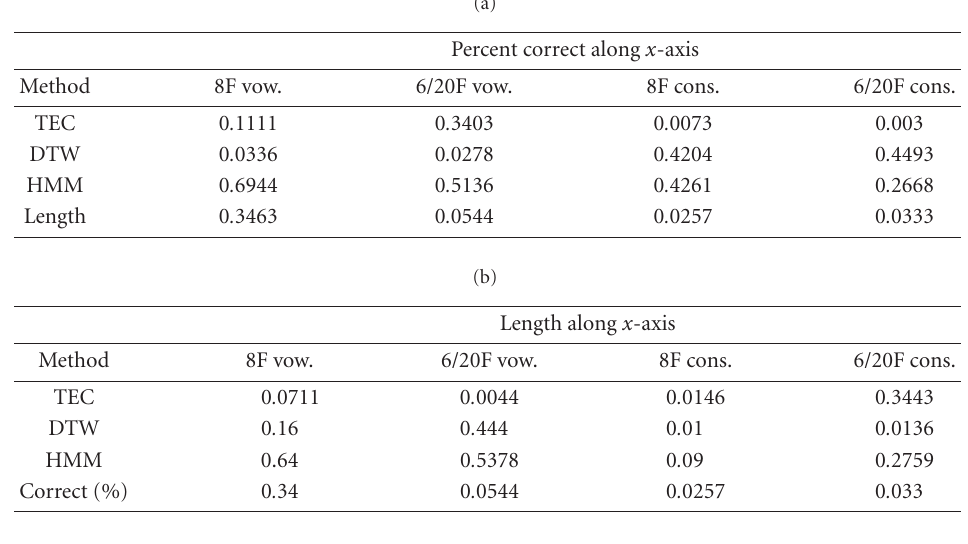
Table 3: Summary of coe ffi cient of determination for linear fittings. R 2 values calculated for percent correct along x -axis (a) and length along x -axis